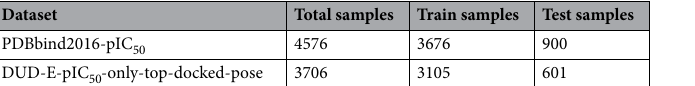
Table 4. Table summarizing the dataset used for pIC 50 regression models.